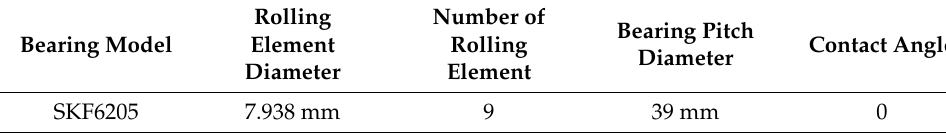
Table 9. Fault characteristic frequency (unit: Hz).